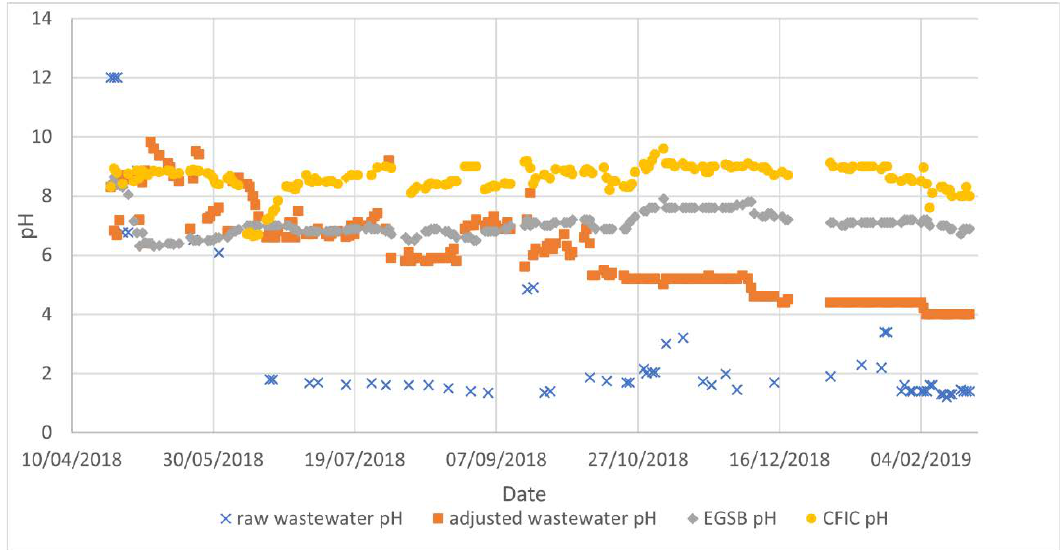
Figure 6. pH at different stages of the pilot study.